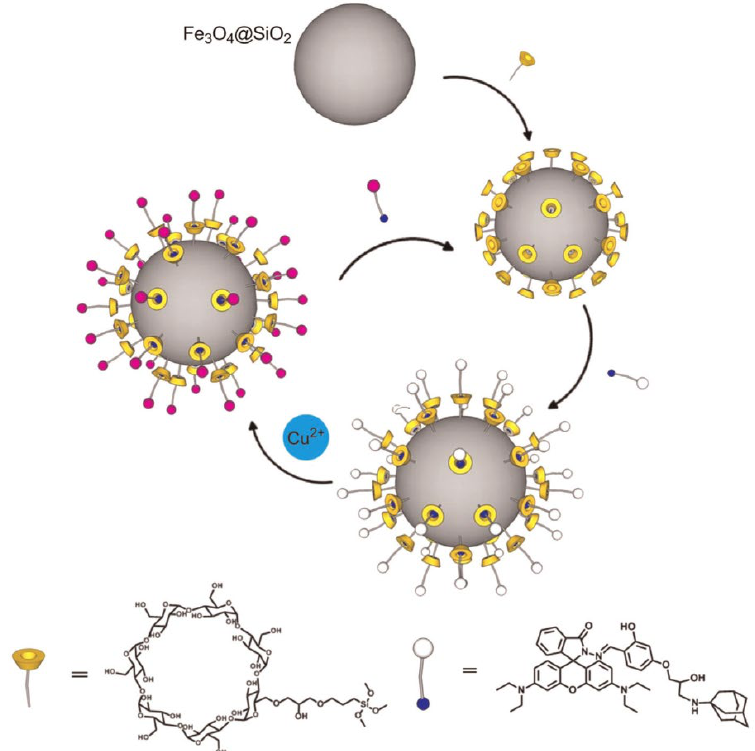
Fig. 14. Chemical and schematic illustration of the preparation of SFIC NMPs sensor for Cu +2 [165]